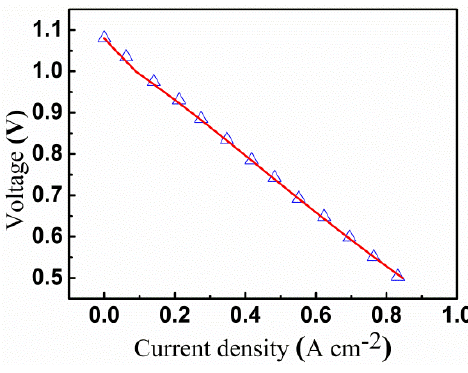
Figure 2. Comparison of the theoretical and experimental I–V relationships. The open symbols and solid lines denote respectively the measured and the calculated results. The thickness of anode support layer and cathode current collector layer are 500 and 45 µm respectively.